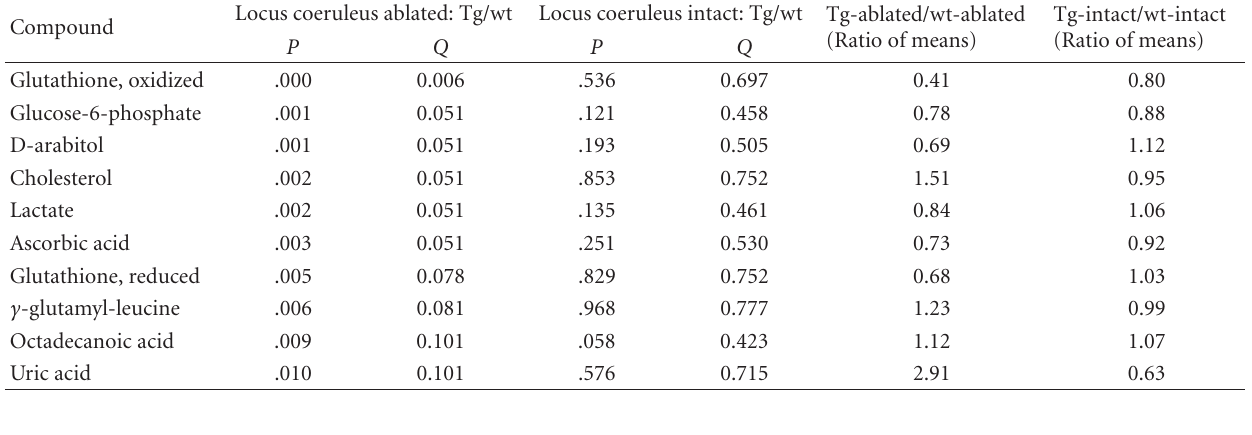
Table 1: The 10 most statistically significant metabolic di ff erences in brain tissue, associated with transgenesis for Tg2576 that were observed after ablation of the locus coeruleus with DSP4 but not in animals in which the locus coeruleus had been left intact. The P -value describes the false positive rate, the Q -value the false discovery rate.